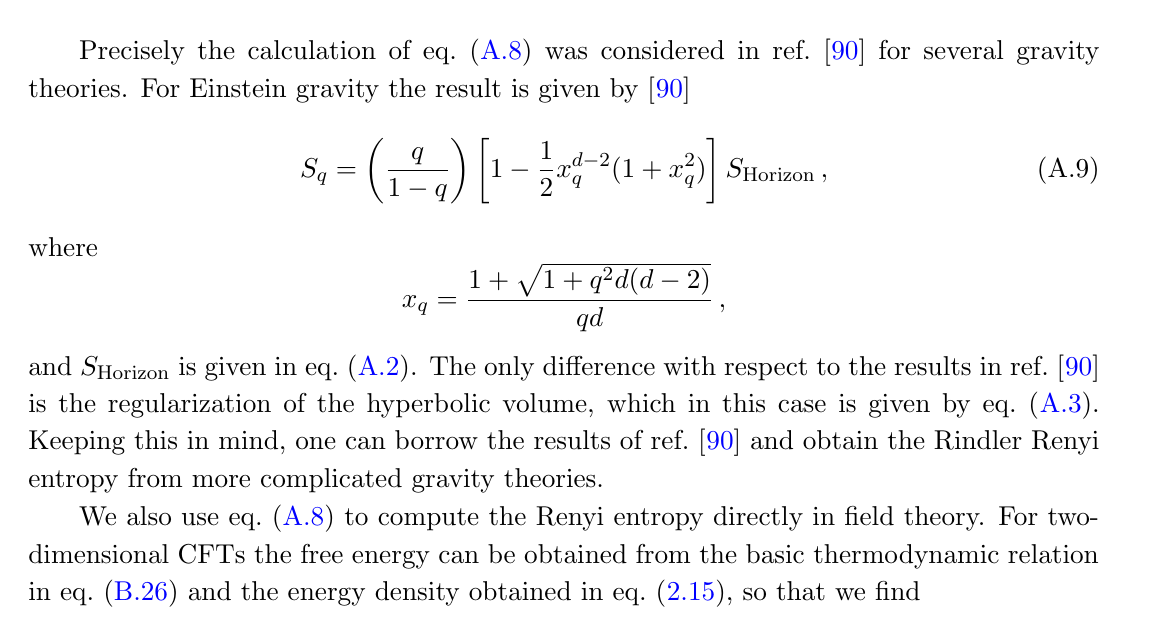
Table 3 . Renyi entropy of the Minkowski vacuum reduced to the half-space for a free massless